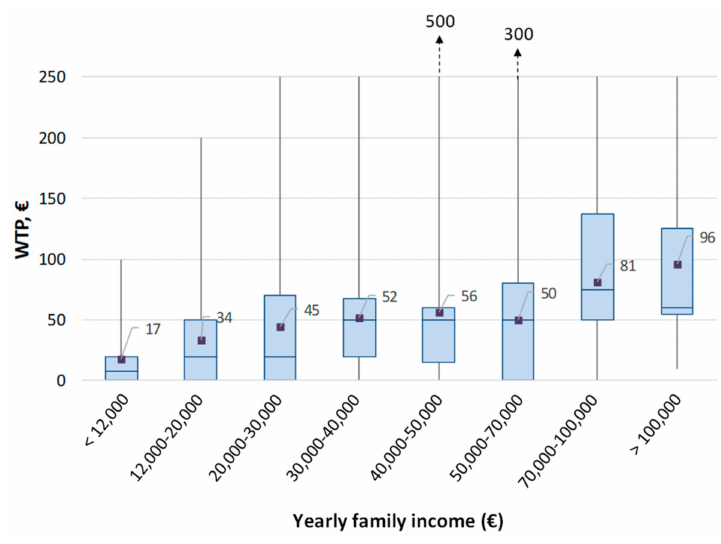
Figure 8. Distribution of WTP with respect to the annual family income.